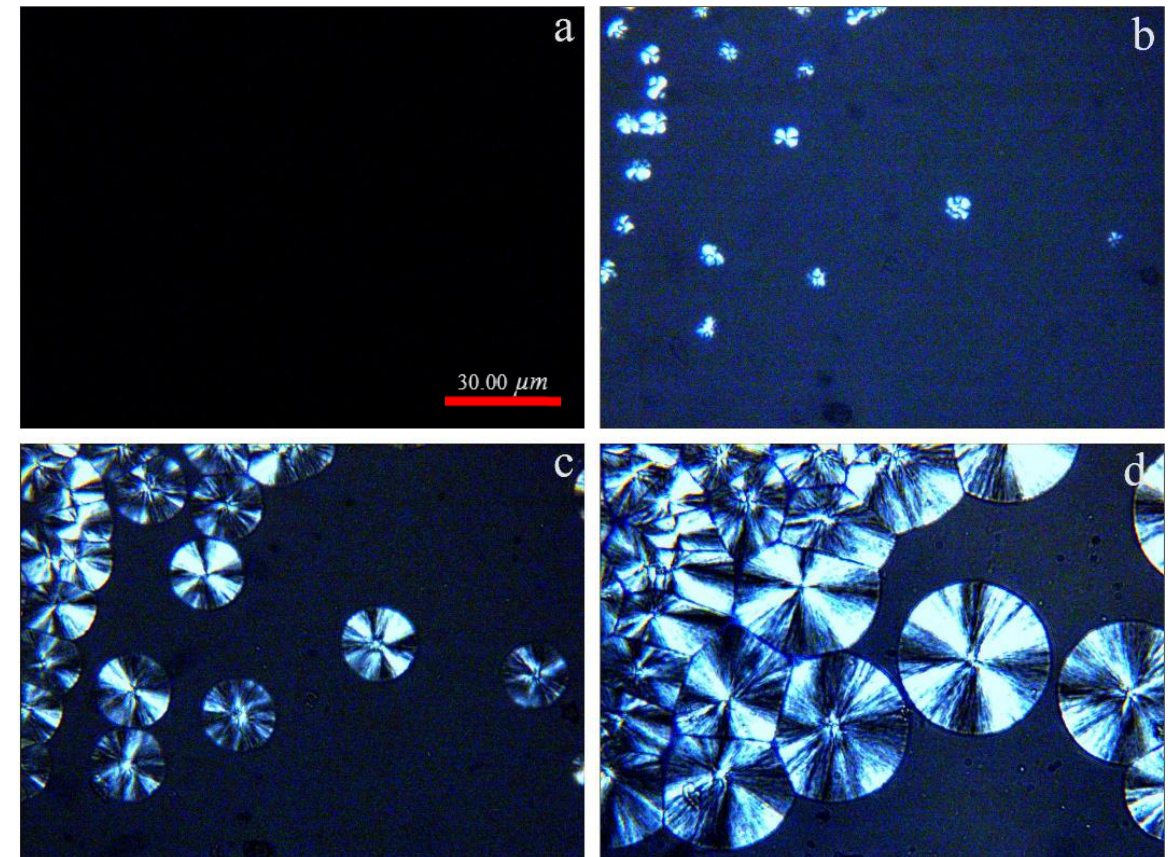
Figure 4 represents the POM of PLLA crystallized isothermally at 120 ◦ C for different periods. Typically, the crystalline morphologies of PLLA are spherulites; the Maltese cross can be observed clearly. As the time increases, the diameter of spherulites increases. Compared to the sample crystallized at 100 ◦ C, the number of nuclei is greatly reduced. This result is due to the fact that the chains diffuse very fast, while the nucleation rate is very slow when crystallization takes place at a higher temperature [29–31].